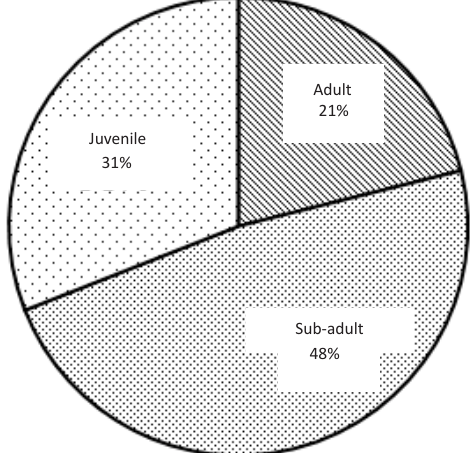
Figure 2. Percentage Age Structure